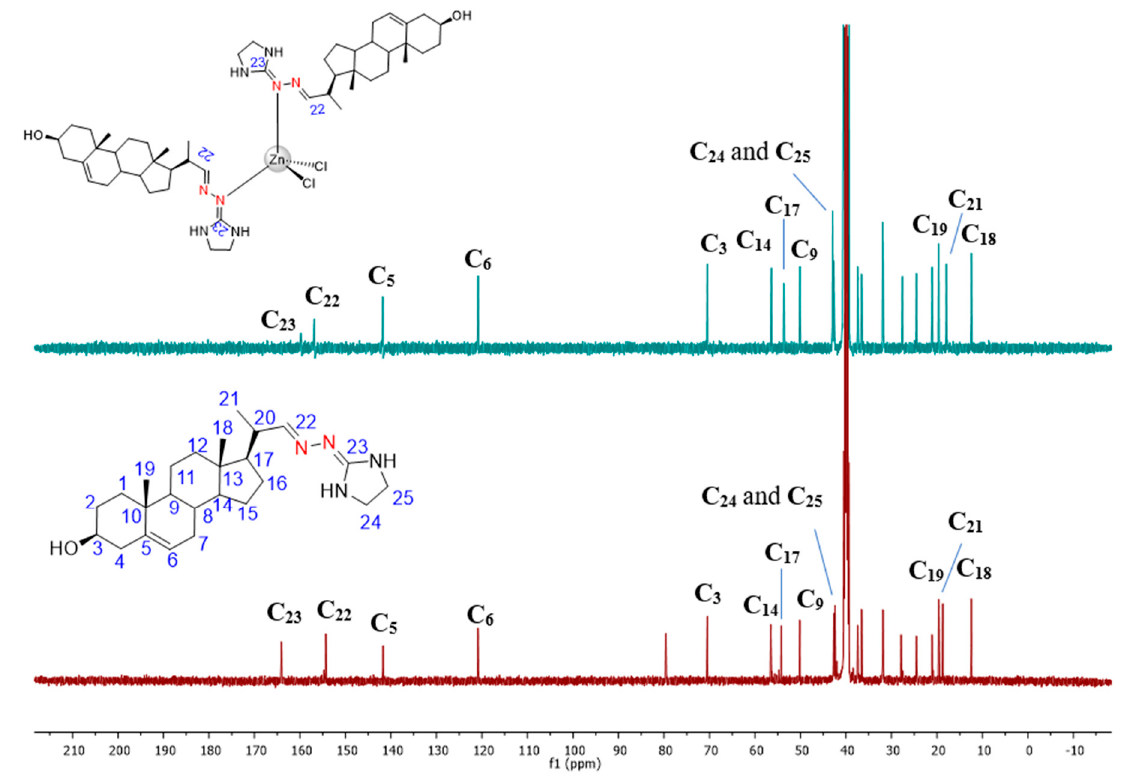
Figure 2. 13 C NMR spectra comparison of the free ligand H3 and ZnCl 2 ( H3 ) 2 complex.